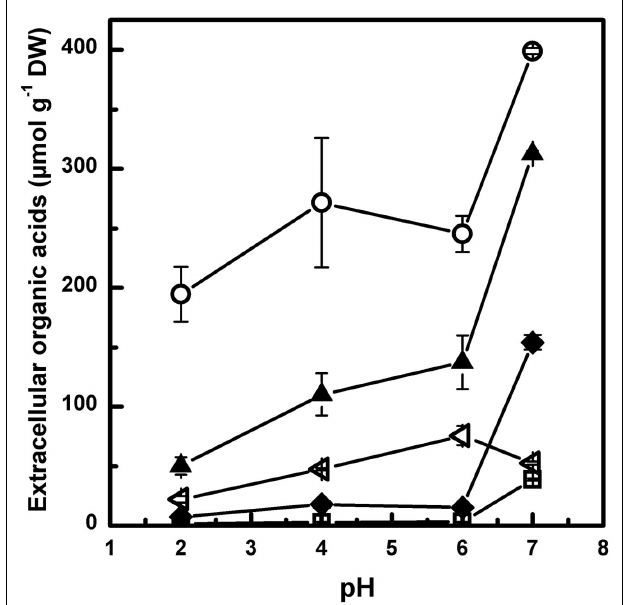
FIGURE 2 | Organic acid excretion of NH 4 -limited chemostat cultures of Penicillium ochrochloron CBS 123824 in response to different ambient pH ( D = 0.090h − 1 ; 30˚C). After a shift in pH, four to six generation times passed before a new steady state was established. Steady state was assumed as soon as the oxygen consumption was constant. Data for each steady state are means of at least four sampling points over a time period of at least 30h. Citrate ( (cid:2) ), oxalate ( (cid:3) ), fumarate ( (cid:4) ), malate ( (cid:2) ), and succinate ( (cid:5) ). Redrawn and modified with kind permission from Gallmetzer